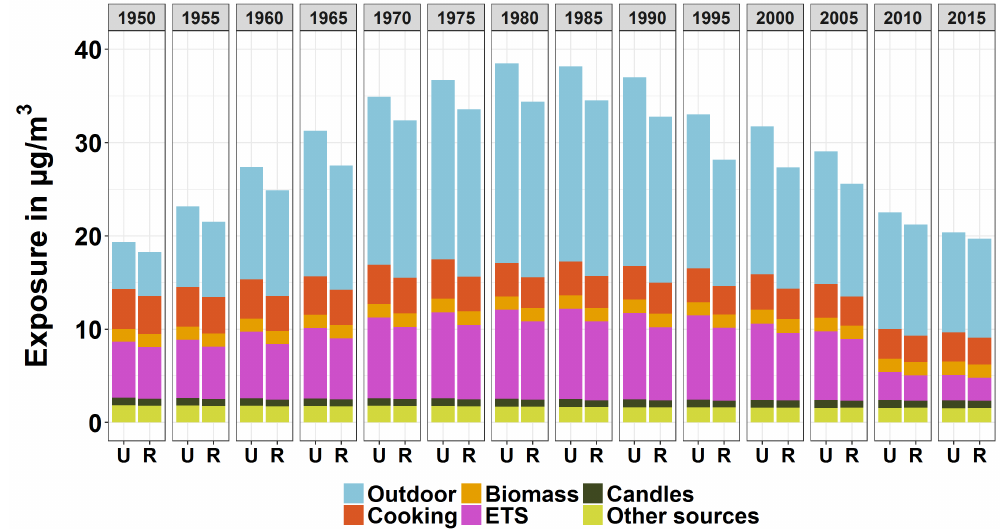
Figure 8. Population-weighted arithmetic mean PM 2.5 exposure by source and degree of urbanisation for European countries from 1950 to 2015. The “U” stands for “Urban or suburban areas” while the “R” stands for “Rural areas”.